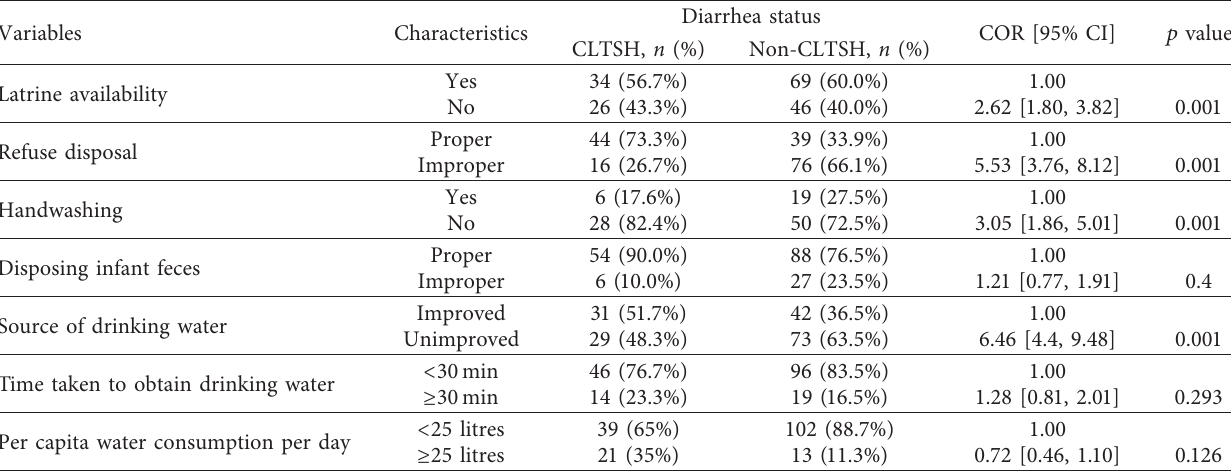
Table 6: Bivariate analysis of environmental factors related to diarrhea among under-five in selected CLTSH implemented and non- implemented woredas in Gamo Gofa Zone, March